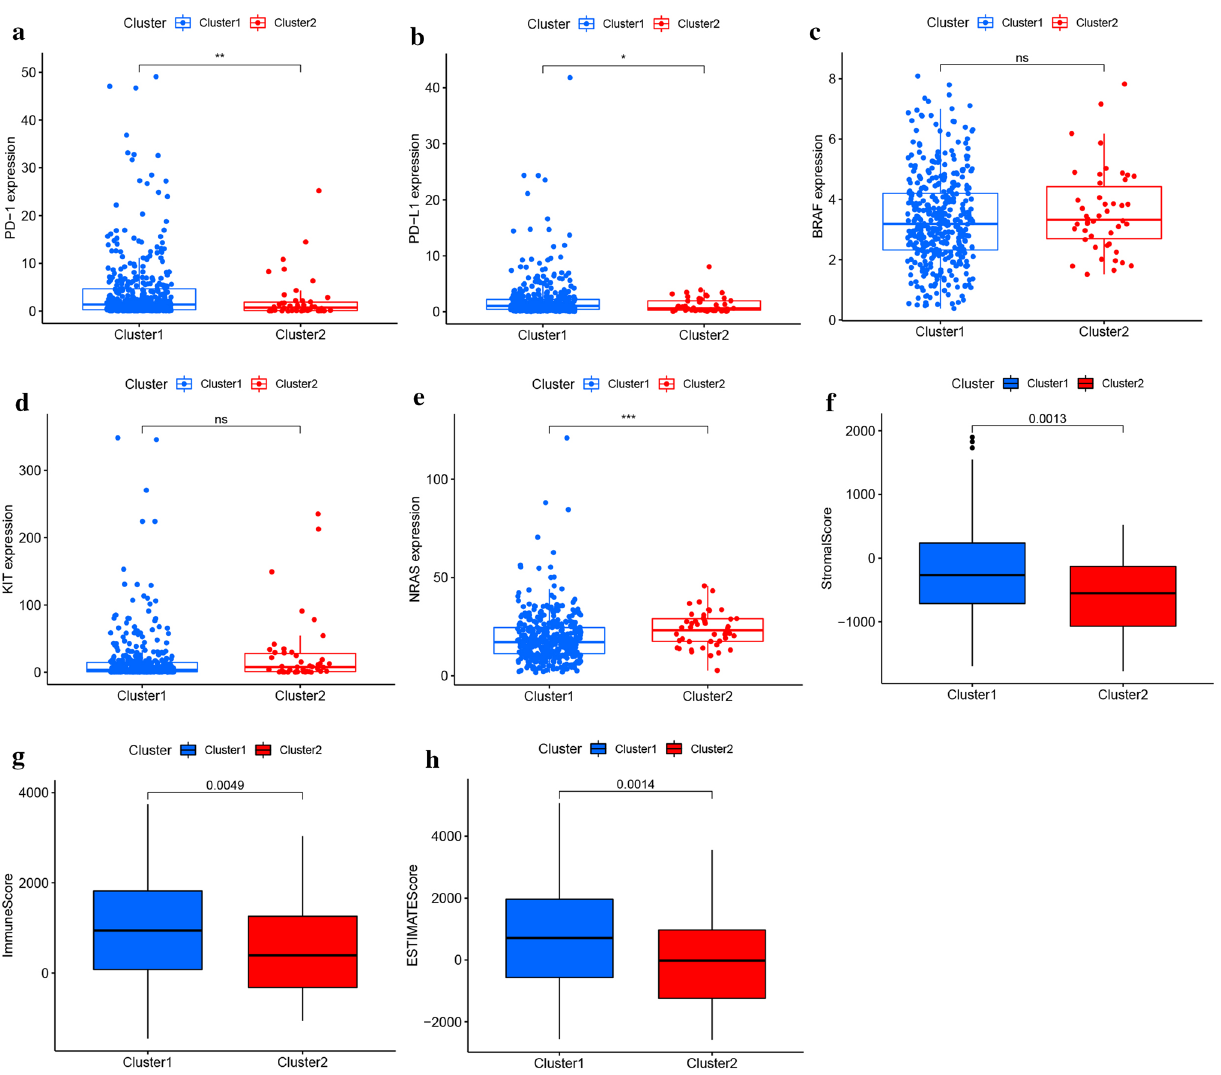
Fig. 2 Gene mutations and the tumor microenvironment in the two clusters. a – b The comparison of immune checkpoint genes expression in the two clusters. c – e The comparison of commonly mutated gene expression in the two clusters. f – h Differences in the immune microen- vironment scores between Cluster 1 and Cluster